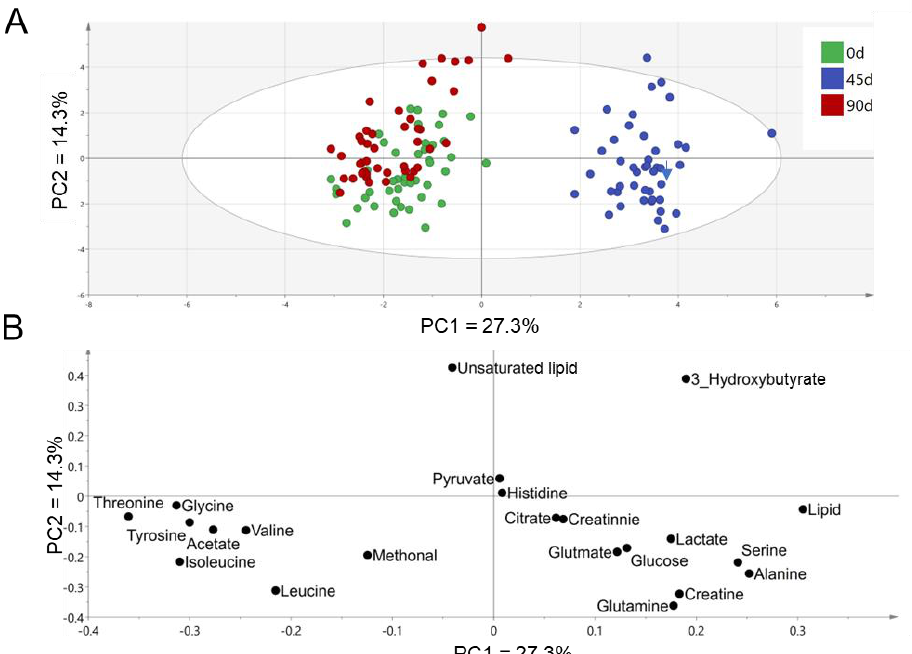
Figure 2. PCA score plot ( A ) and loading plot ( B ) based on metabolites identified from plasma 1 NMR spectra. n = 44, each group. spectra. n = 44, each